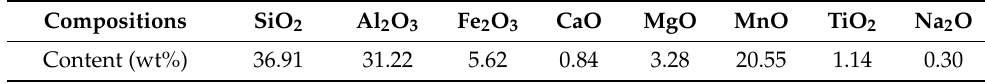
Table 2. Chemical compositions of slag used for testing.